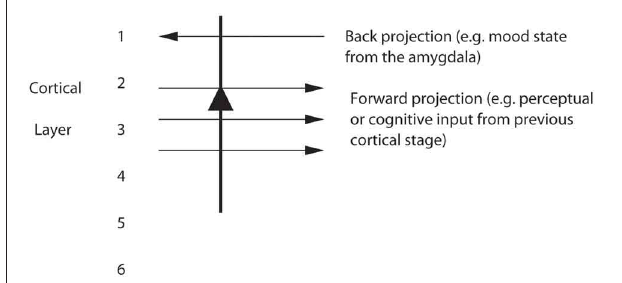
FIGURE 7 | Pyramidal cells in, for example, layers 2 and 3 of the temporal lobe association cortex receive forward inputs from preceding cortical stages of processing, and also backprojections from the amygdala. It is suggested that the backprojections from the amygdala make modifiable synapses on the apical dendrites of cortical pyramidal cells during learning when amygdala neurons are active in relation to a mood state; and that the backprojections from the amygdala via these modified synapses allow mood state to influence later cognitive processing, for example by facilitating some perceptual